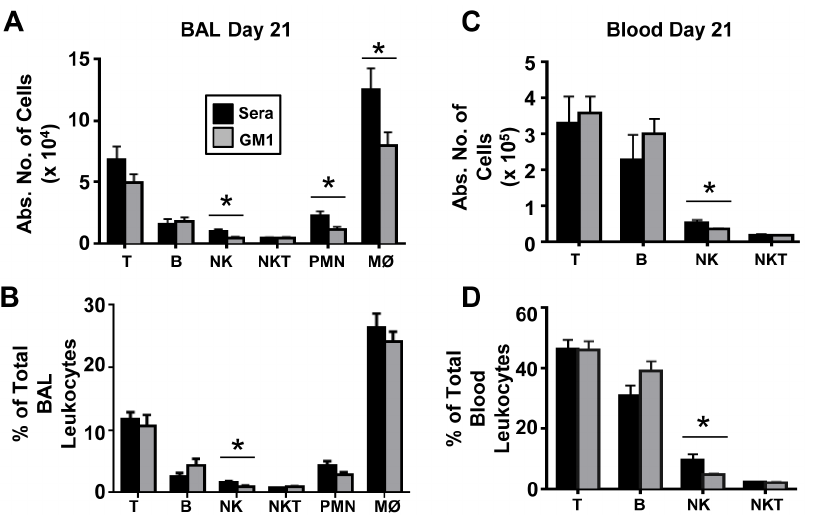
Figure 4. Anti-asialo GM1 treated mice maintain depleted levels of NK cells at day 21 after bleomycin injection. At day 21 after bleomycin injection, leukocytes were isolated from BAL fluid ( A, B ) or blood ( C, D ) and stained with specific antibodies against NK cells (DX5); T cells (TCR b ), B cells (CD19) and NKT (TCR b + DX5 + ), neutrophils (Ly6G), and macrophages (F4/80) and analyzed by flow cytometry. Mean 6 SEM of n=8–10 mice per group. *p , 0.05, ** p , 0.01 by 2 way ANOVA followed by t -test.